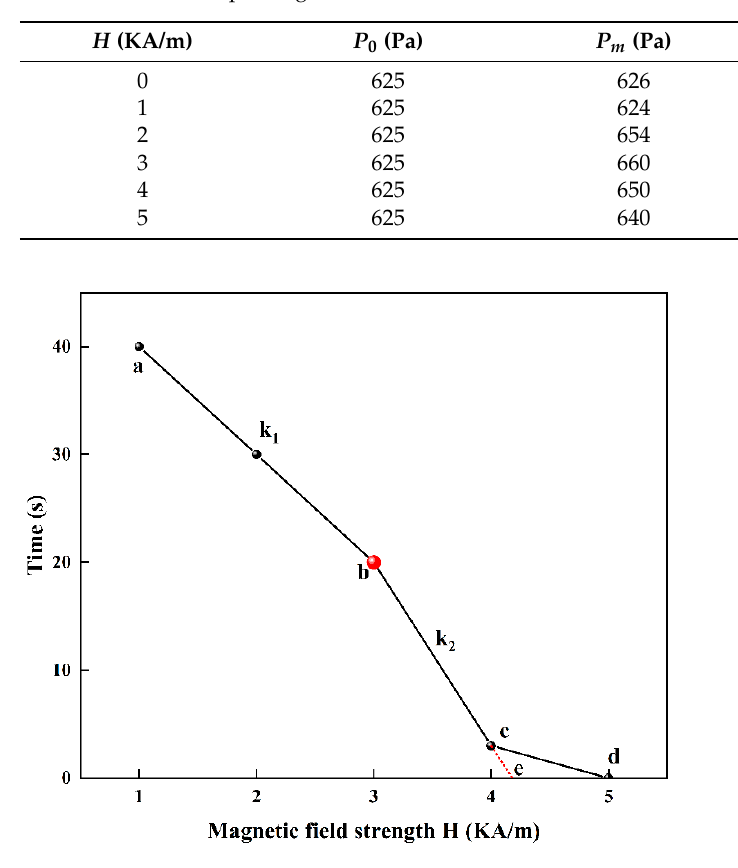
Figure 6. ‘Sudden change of pressure drop’ in the bed of ‘adding magnetic field later’. Table 2. Pressure drop change schedule.